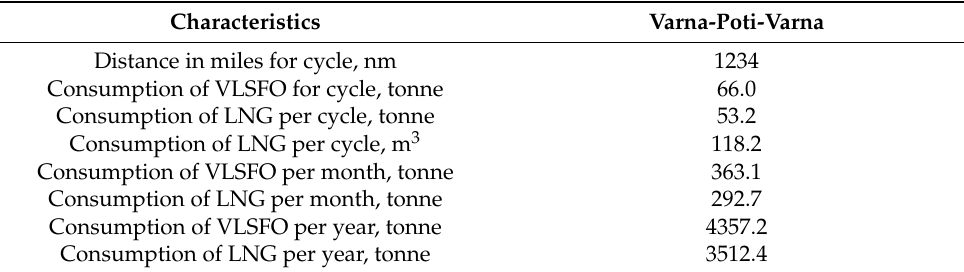
Table 8. Summary of the results for the two